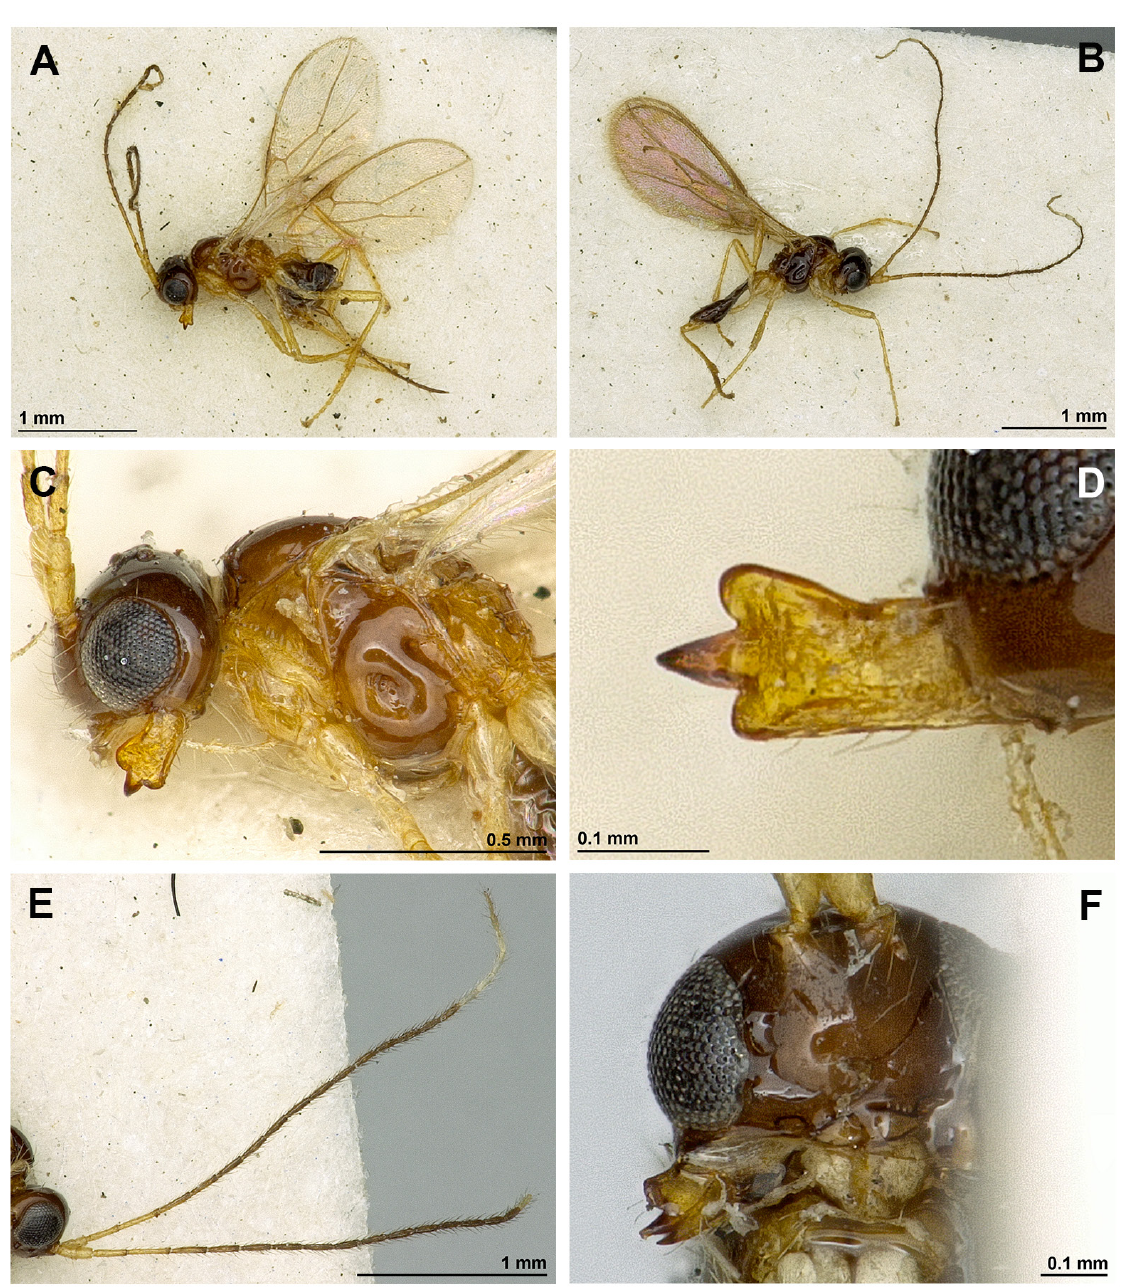
Fig. 3. Asobara apicalis Fischer, 2003, A, C–F: ♀, holotype (ZSSM); B: ♂ (NHMW). A–B . Habitus, lateral view. C . Head and mesosoma, lateral view. D . Mandible. E . Antenna. F . Head, front